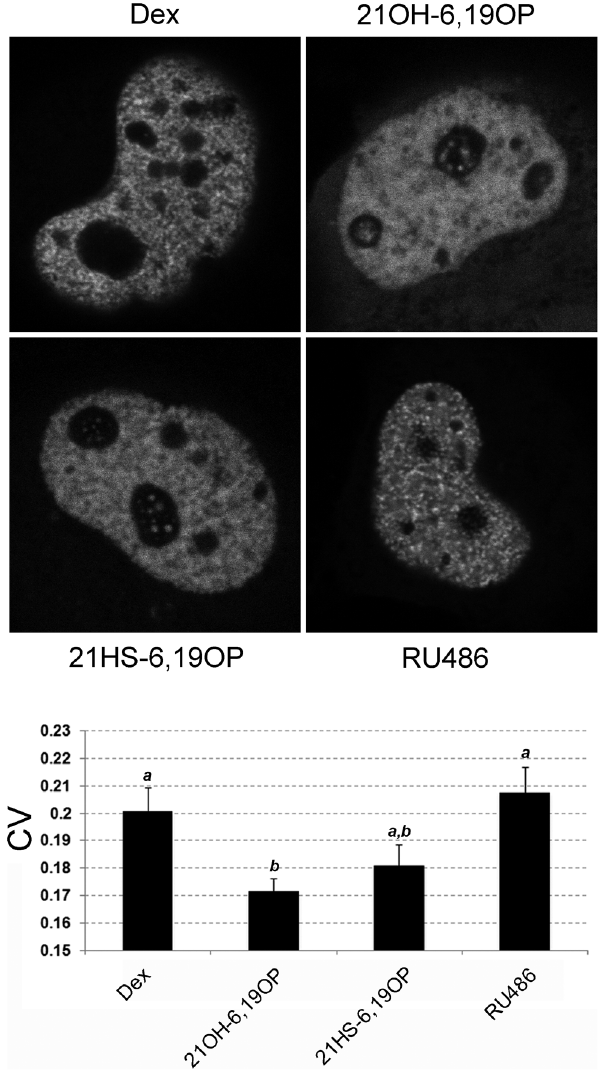
Figure 1. Intranuclear distribution of GFPGR. Cos-7 cells transfected with pEGFPGR were incubated with 10 nM Dex, 10 m M 21OH-6,19OP, 10 m M 21HS-6,19OP or with 1 m M RU486 for at least 40 min at 37 C. Cells were visualized by confocal scanning microscopy. Images were taken between 40 min-3 h after addition of the steroids. The figure shows representative cells for each treatment and the coefficient of variation (CV) quantitation as described in ‘‘Materials and Methods’’. Bars with different superscript letters are significantly different from each other ( P , 0.05).